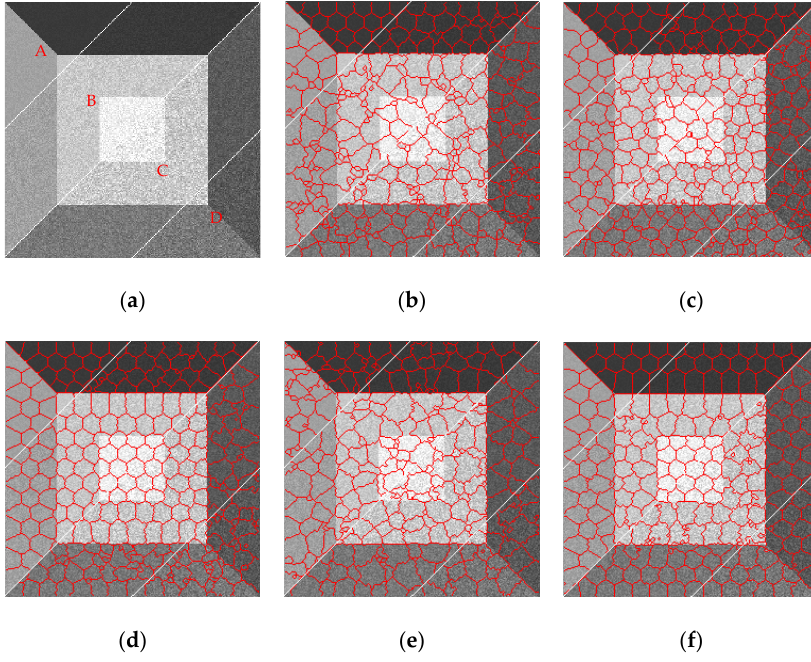
Figure 14. Resulting superpixels with m set to eight, K set to 240, and v set to 0.001, 0.004, 0.007, and 0.01 for regions A, B, C, and D, respectively. ( a ) Original; ( b ) SLIC; ( c ) PILS; ( d ) LBSLIC; ( e ) PBSLIC; ( f ) PSDSD.